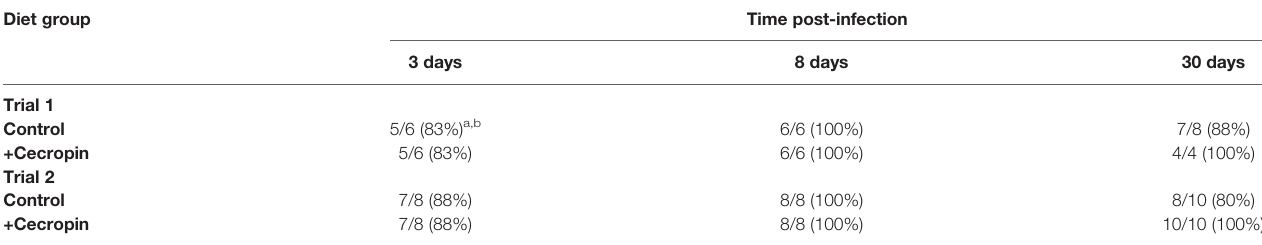
TABLE 1 | Detection of Y. ruckeri 16S DNA in intestinal extracts by qPCR. Diet group